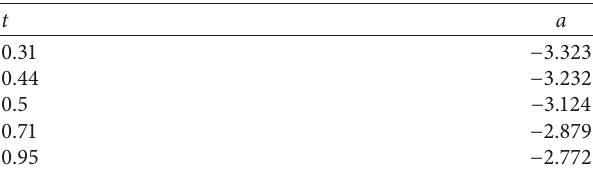
Figure 6: Acceleration test chart. (a) eDAQ data collector. (b) Acceleration test. Table 5: ASC acceleration sensor.